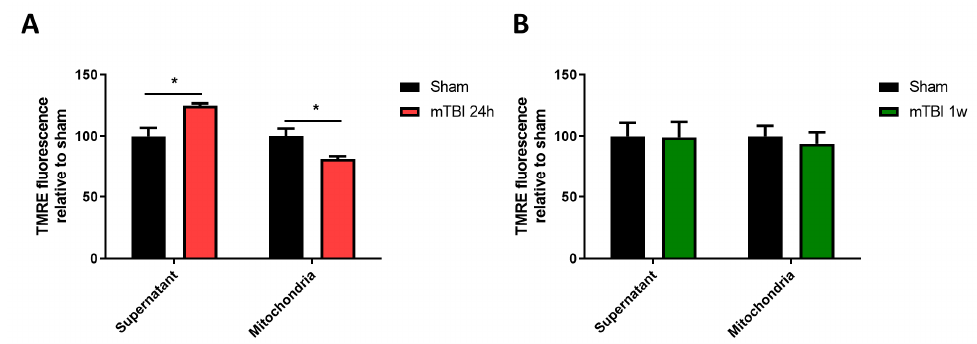
Figure 2. mTBI induces early and partial mitochondrial depolarization. ( A ) TMRE exclusion assay in mTBI-derived mitochondria 24 h after protocol indicating relative levels of TMRE in supernatant and mitochondria. ( B ) TMRE exclusion assay in mTBI-derived mitochondria one week after protocol. Student’s t -test for supernatant and mitochondria separately. * p < 0.05.